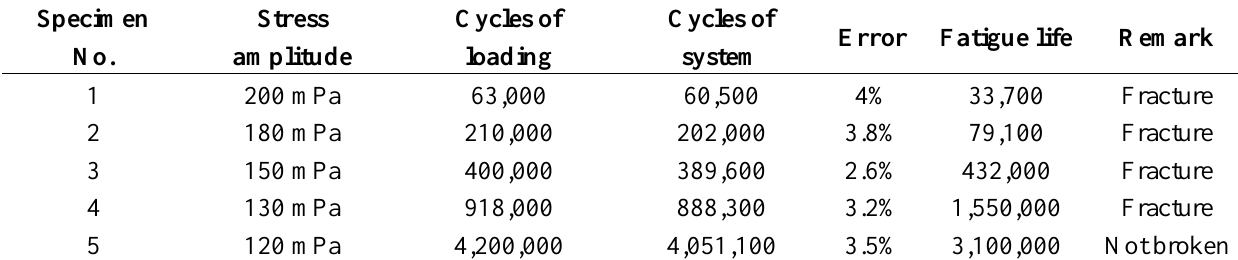
Table 5. Fatigue test result based on strain gauge.